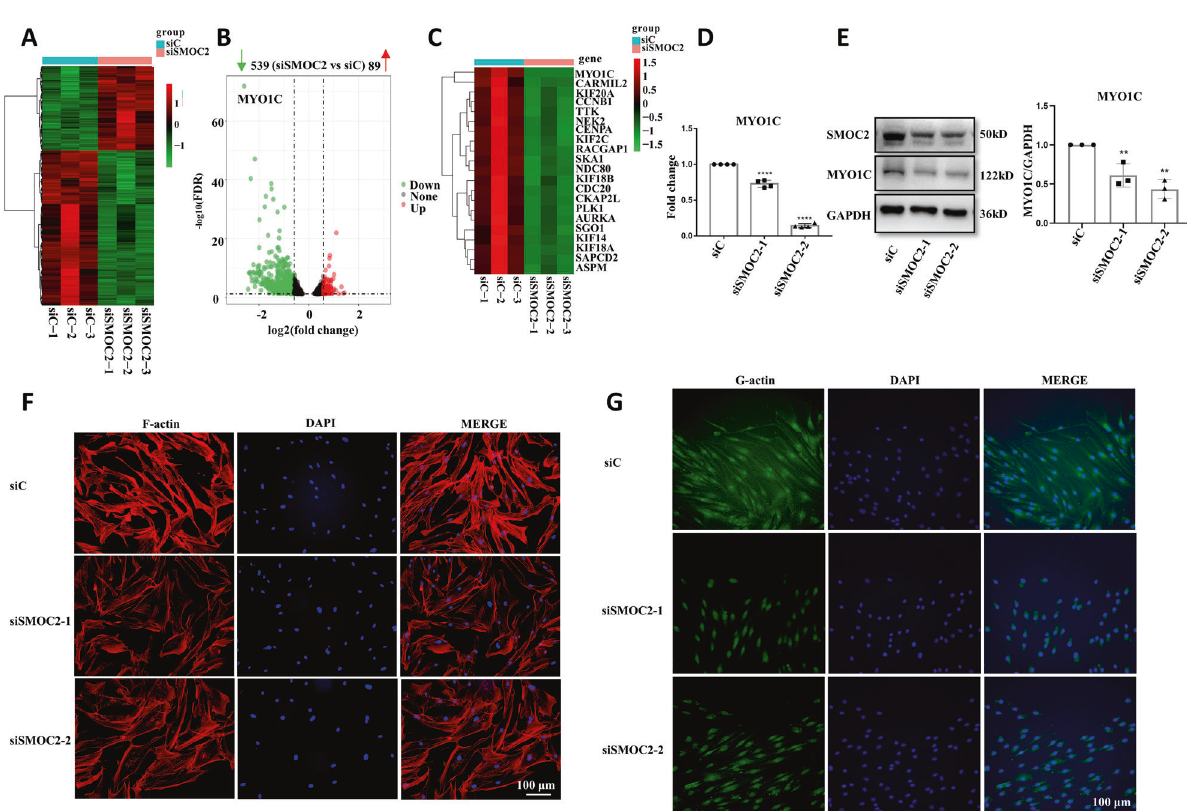
Fig. 3 Identi fi cation of MYO1C as a downstream target of SMOC2 in RA FLSs. A , B Heatmap with hierarchical clustering and volcano plot analysis reveal differentially expressed mRNAs between RA FLSs transfected with SMOC2 siRNA (si-SMOC2-2) and those transfected with the control siRNA (siC) (FC-abs >1.5 and p -value < 0.05). Among which, MYO1C was the most downregulated gene. C Heatmap analysis of cytoskeleton-related genes in SMOC2-knockdown RA FLSs (FC-abs > 1.5 and p -value < 0.05). D Effect of SMOC2 knockdown on the mRNA expression of MYO1C. E Effect of SMOC2 knockdown on the protein expression of MYO1C. F , G Cell immuno fl uorescence was performed to detect alterations in the actin cytoskeleton in RA FLSs with SMOC2 knockdown. F Phalloidin (red) was used to stain F-actin, while DAPI (blue) was used to stain the nuclei. Original magni fi cation, ×200. G DNase I (green) was applied to stain G-actin, while DAPI (blue) was used to stain the nuclei. Original magni fi cation, ×200. Data are presented as the mean ± SD. **** p <